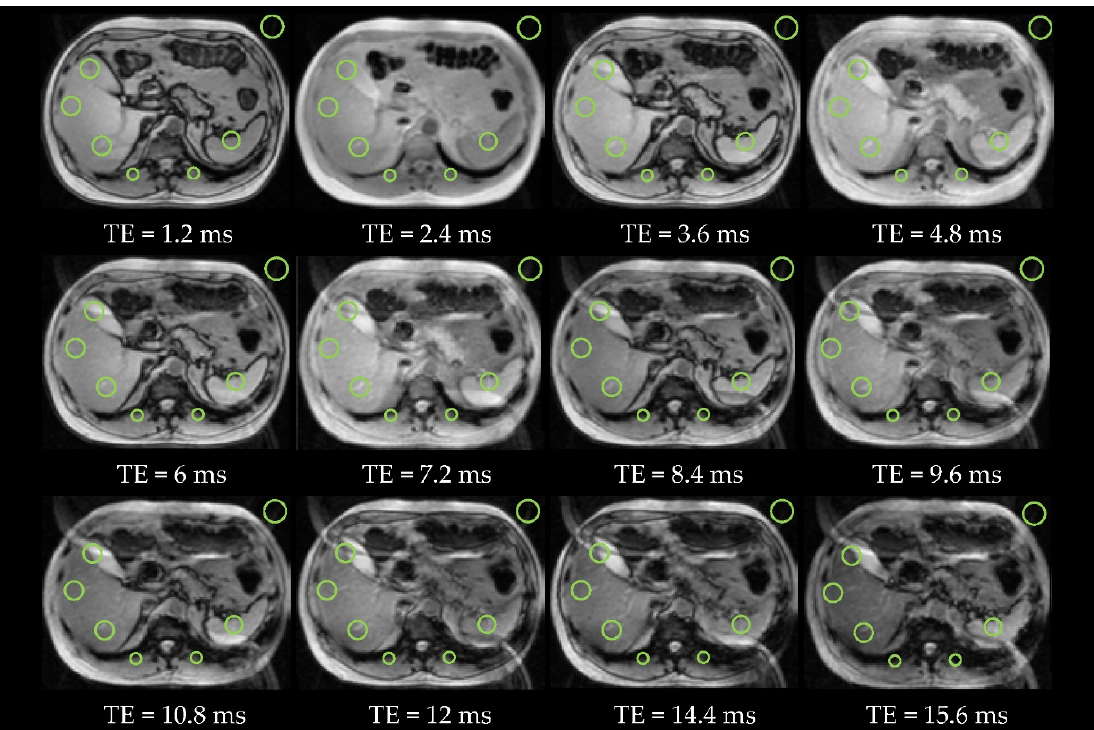
Figure 7. Patient #6 with absence of iron overload and severe steatosis at 1.5T ( T2 * = 17.5 ms and LIC = 34 µmol/g). There are 10 echoes with a duration of 2.4 ms each echo. The OOP images are with TE = 2.4 ms, 7.2 ms, 12 ms, 16.8 ms, and 21.6 ms and IP images are with TE = 4.8 ms, 9.6 ms, 14.4 ms, 19.2 ms, and 24 ms. There are 3 ROis in the liver, 2 ROIs in paravertebral muscles, 1 ROI in the spleen and 1 ROI of background noise.